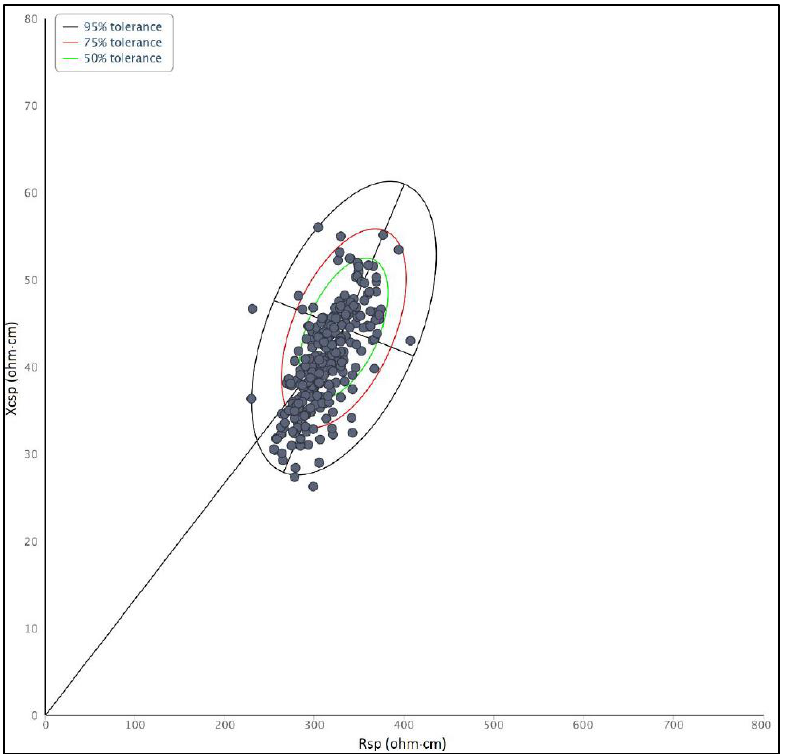
Figure 1. Distribution of bioelectrical values of Brazilian Military onto tolerance ellipses representing Italian-Spanish young adults, at the beginning of the routine year.